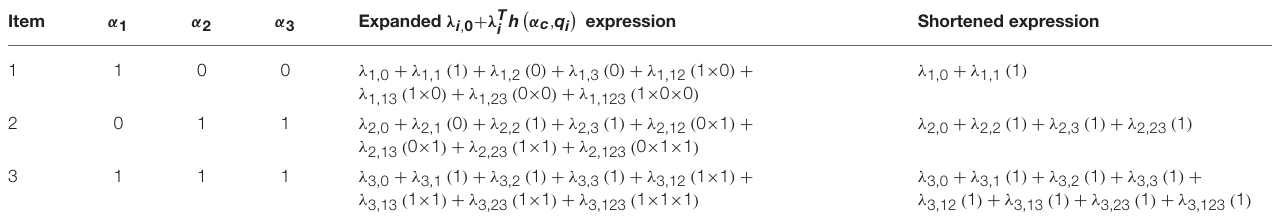
TABLE 2 | A 3-item sample of expressions of a log-linear cognitive diagnostic model. Item expression Shortened